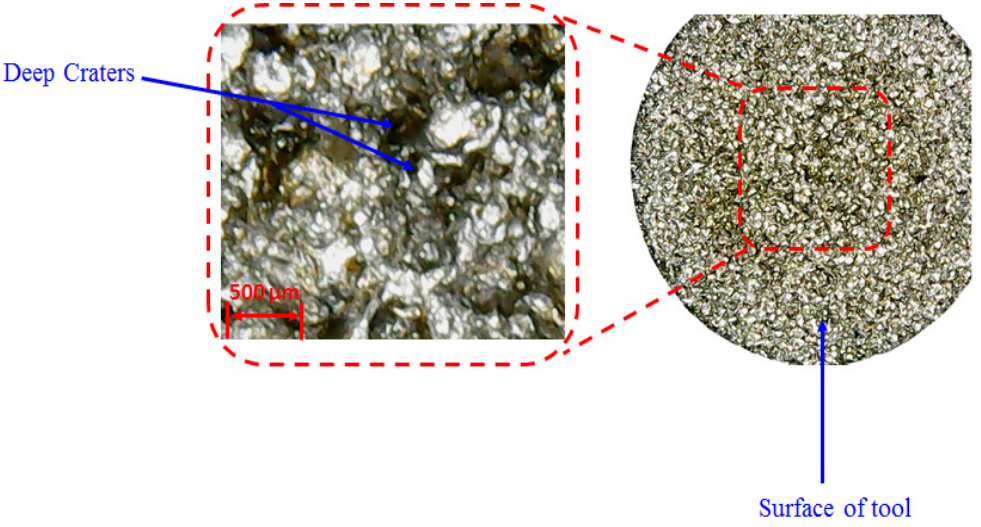
Figure 8. Micrograph of Aluminium electrode.